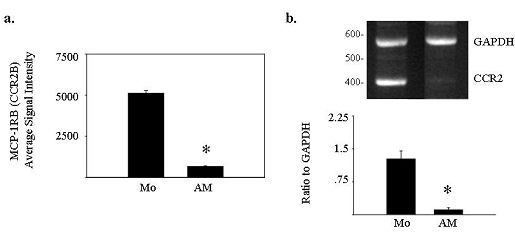
Alveolar macrophages express less CCL2R/CCR2 RNA than peripheral blood monocytes. Using 10 μg of total RNA extracted from freshly isolated peripheral blood monocytes or alveolar macrophages, single stranded cDNA was synthesized and subjected to microarray analysis (n = 2) or 30 cycles of multiplex PCR using primers for CCR2 and GAPDH. Affymetrix microarray analysis indicated that a) alveolar macrophages express less CCL2RB (HG-U95Av2 39937 at, Accession No. U03905) than peripheral blood monocytes (*p < 0.05). b) Reverse transcriptase PCR for CCR2 confirmed these results. The bands shown in (b) are representative of 3 independent experiments from matched donors different than those used in (a), and the corresponding graph shows the ratio of CCR2 to GAPDH control band intensity by densitometry, averaged over the three donors ± SEM (*p < 0.05 for CCR2 expression in alveolar macrophages compared to monocytes from the same donors).